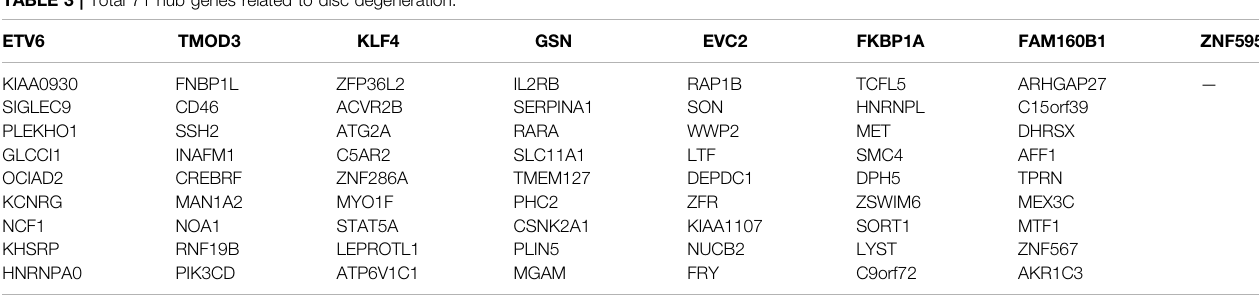
TABLE 3 | Total 71 hub genes related to disc degeneration.